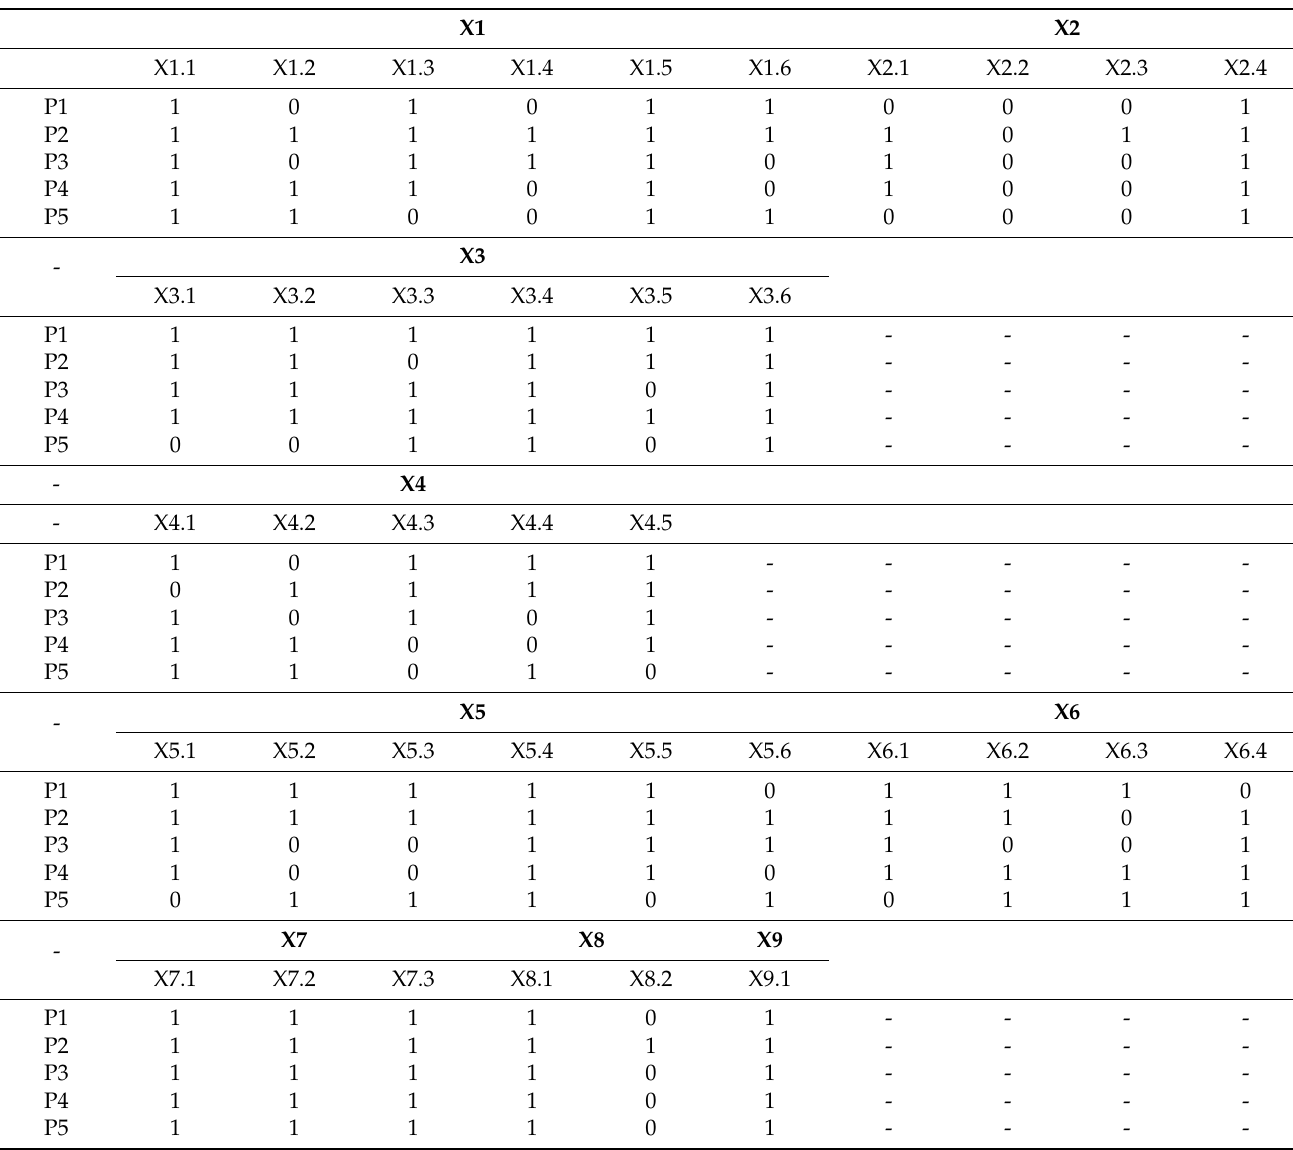
Table 7. Multiple input and output table.